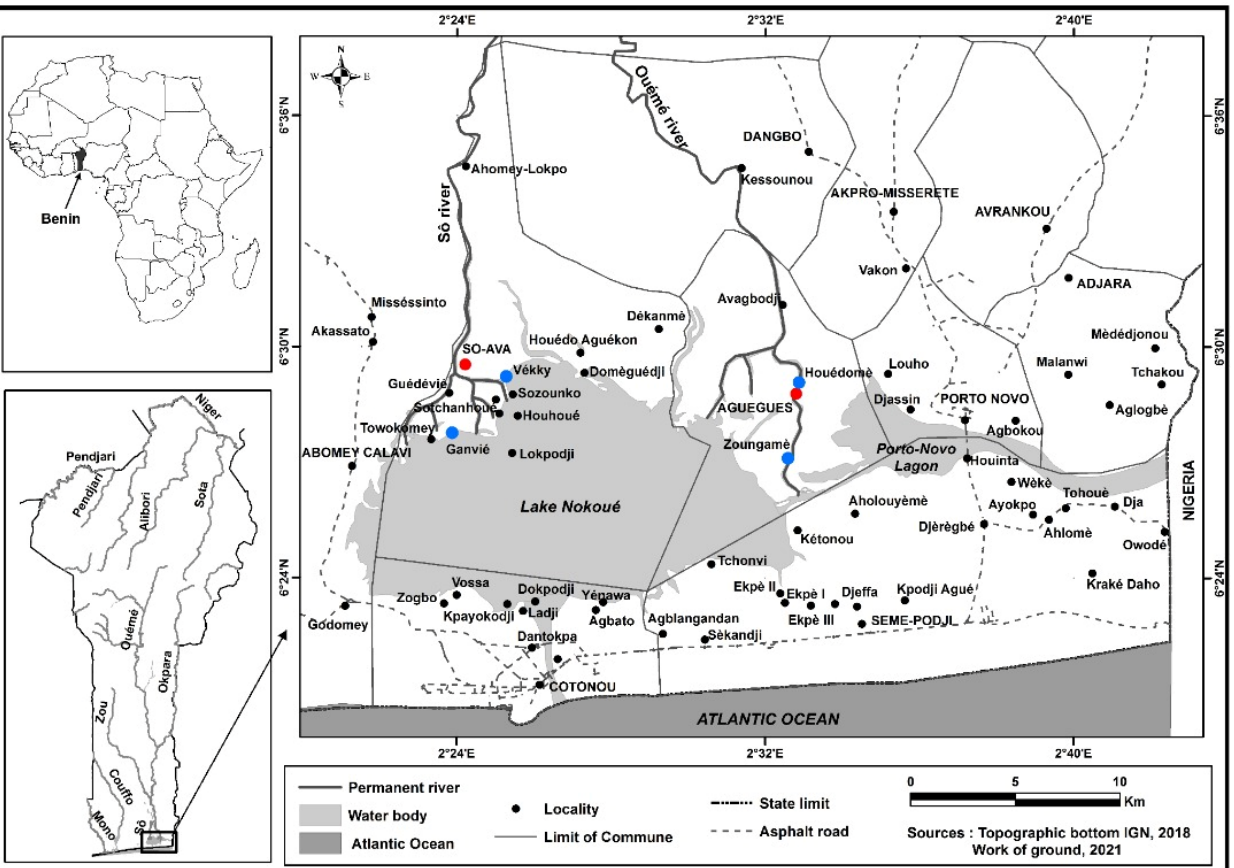
Figure 1. Map of the study area in the southeast of Benin. ( Top left ): Benin is located in West Africa. The country is key-shaped and runs almost vertically from the Atlantic Coast in the south to the north. ( Bottom ): The study zone is located in southeast of Benin, along the coastal area. ( Right ): Estuarine and lagoon complex of Lake Nokoué–Lagoon of Porto-Novo in grey. The red point indicates the two surveyed towns “So-Ava” and “Les Aguégués”, and in blue, there are the 4 sub-districts in which villages were chosen. Source: Made by authors.